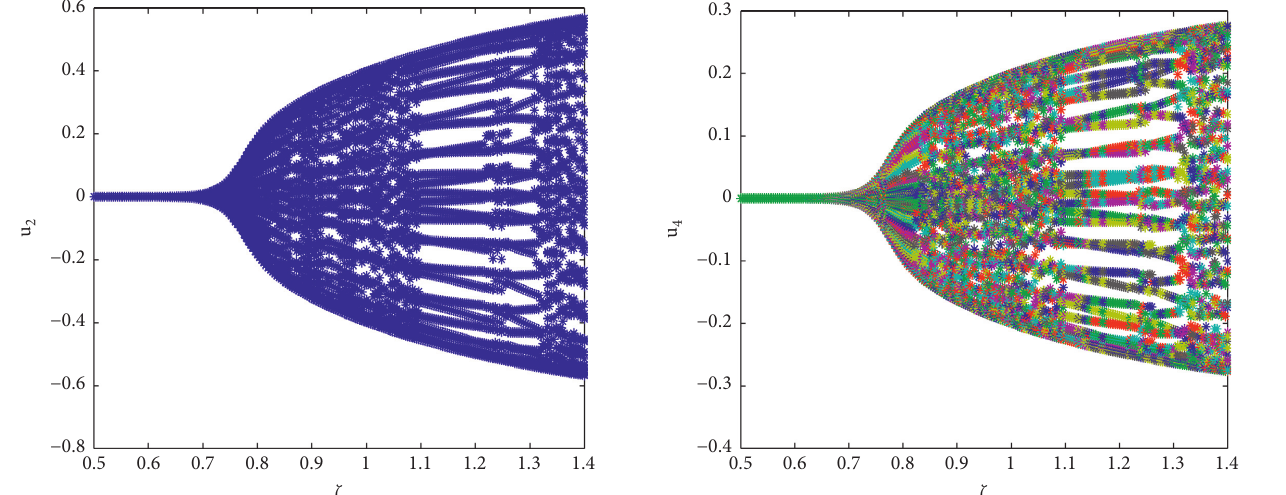
Figure 6: Bifurcation figure of neural network model (4.2): ζ - u . 2